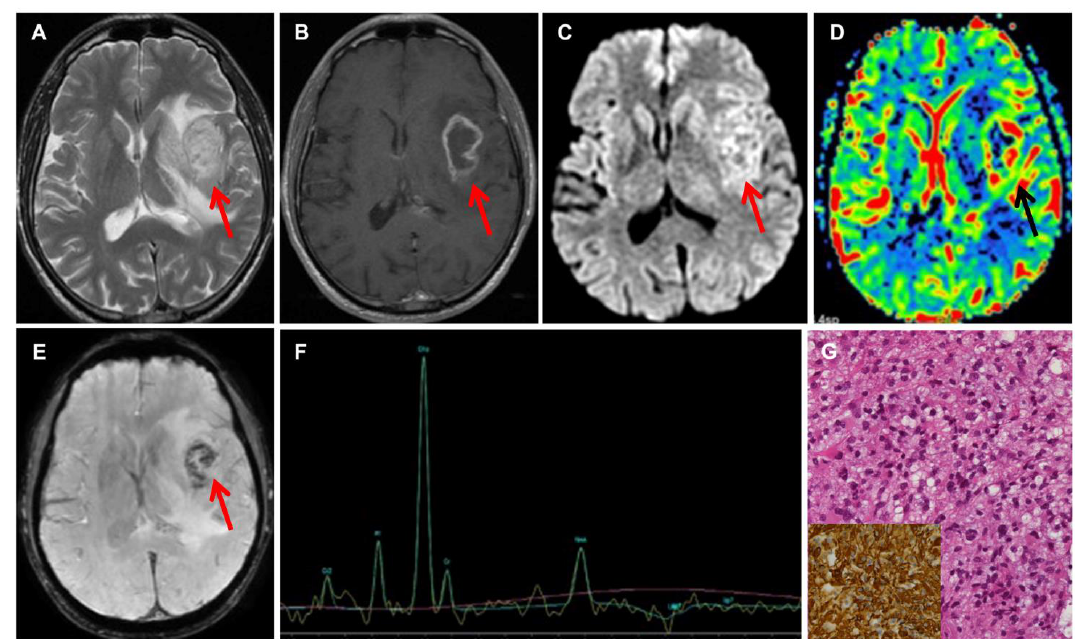
Figure 2. Neuroradiological and histological features of HGG. Axial T2-weighted ( A ) and axial Gd-enhanced T1-weighted ( B ) MR imaging showing a heterogeneous mass in the left insula and basal ganglia, with irregular ring enhancement, corresponding to areas of restricted diffusion on DWI ( C ) and elevated perfusion on CBV map ( D ). SWI ( E ) shows extensive “blooming” foci, consistent with intratumoral hemorrhage. Arrows point at the tumor ( A – E ). MRS ( F ) shows elevated Cho and decreased NAA. MRI features are consistent with GBM. The neuropathological examination confirms the presence of a high-grade diffuse astrocytic glioma ( G ) with evidence of vascular proliferation (not shown). The tumor is IDH -wt and shows strong immunoreactivity for GFAP ( G , inset).